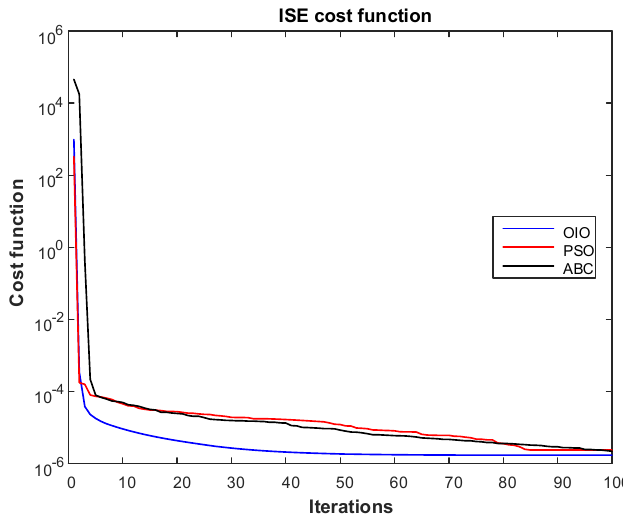
OIO PSO ABC Figure 18. Iteration history for ITSE. Total optimization times for each method and algorithm are given in Table 6. OIO algorithm realized optimization process in a shorter time for both test systems. The number of mirror used in OIO algorithm corresponds to the number of population. The number of mirror was specified as 2 in implemented optimizations. The number of population for artificial bee colony for is 3 and 4 for particle swarm optimization. When the number of population is decreased it is seen that the methods occur to have the problem of convergence. All parameters used in all three algorithms are presented in Appendix A.